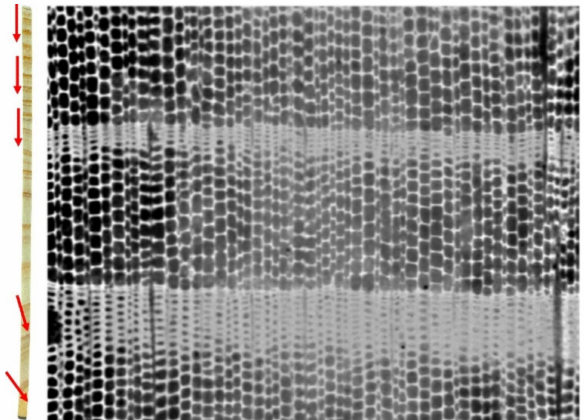
Figure 4. A typical surface image used by SilviScan to determine fibre dimensions on the right-hand side. On the left is a SilviScan bark-to-pith strip prepared from the increment core that was missing the pith. The red arrows illustrate the orientation of the rays (and the direction of the pith), that are vertically aligned in the microscope image used by SilviScan. The width of the radial strip in the left-hand image is 2 mm. The right-hand image from top to bottom represents 1 mm of radial